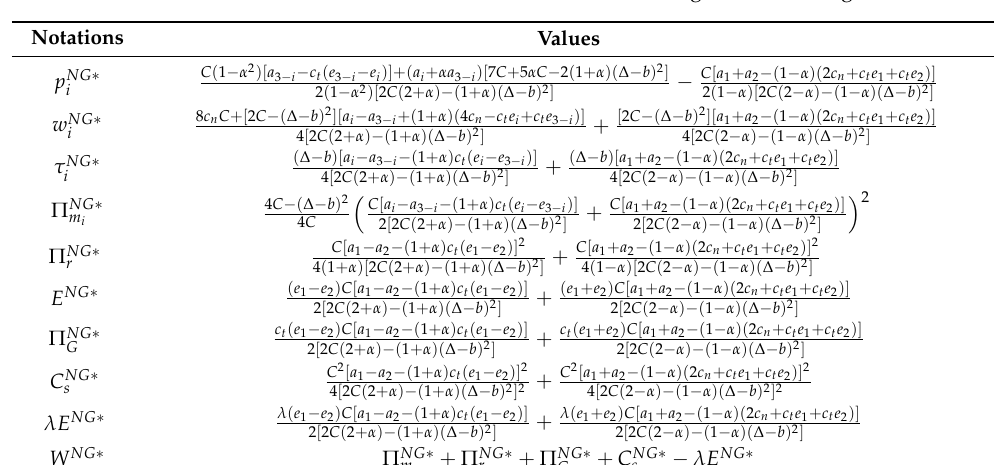
Table 3. Main results for the decentralized model of retailer without green marketing, i = 1, 2.